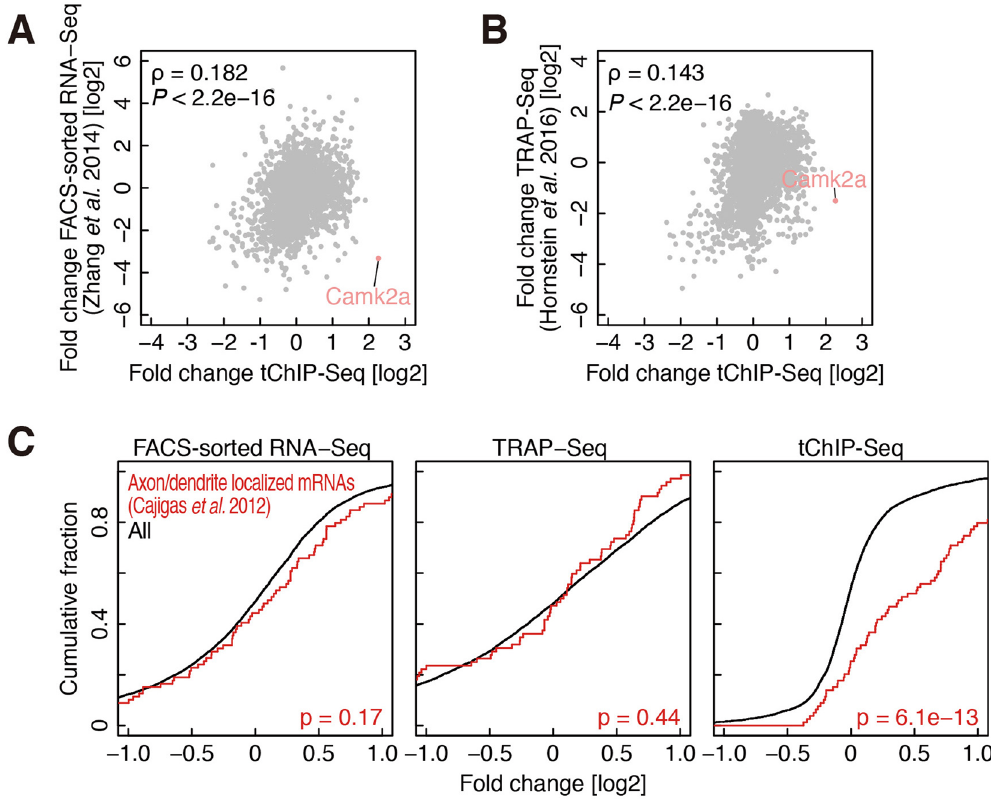
Figure 4. Comparison of tChIP-Seq to previously reported methods for neuron-specific gene expression. ( A and B ) Correlation of tChIP-Seq enrichment and FACS-sorted RNA-Seq ( A ) and TRAP-Seq ( B ). ρ : Spearman’s rank correlation. P value is calculated by Student’s t test. ( C ) Cumulative distribution of axon/dendrite-localized transcripts along FACS-sorted RNA-Seq, TRAP-Seq, and tChIP-Seq. Significance is calculated by Mann- Whitney U